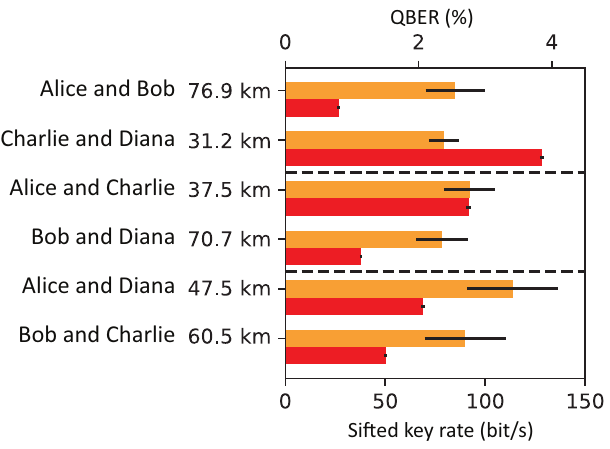
FIG. 7. The QBERs (orange) and sifted key rates (red) for all combinations of the four participants, Alice, Bob, Charlie, and Diana, over different fiber lengths. Fiber spools are assigned as shown in Fig. 2(a). The data are obtained during three 20- run measurements via simultaneous pairwise key exchange. The dashed lines separate the results of the three measurements. The error bars represent the standard deviation of the results for each combination.